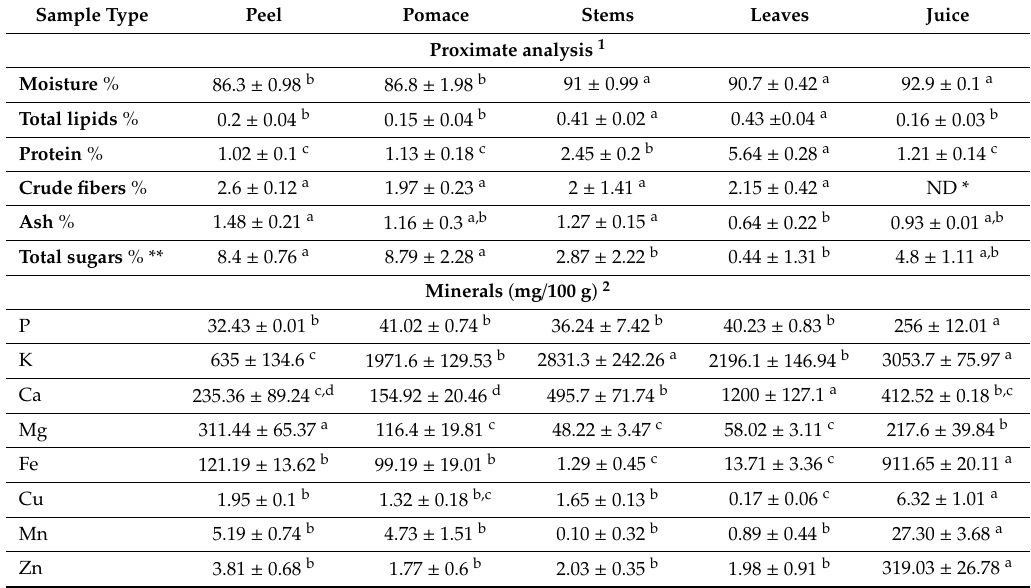
Table 1. Proximate chemical composition and minerals content of beetroot plant